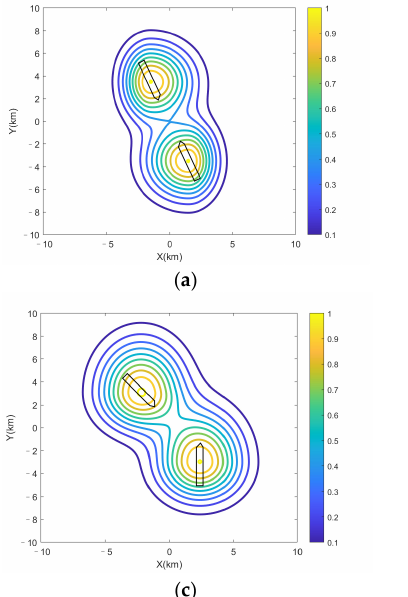
Figure 4. Schematic diagram of ship risk field in different situations: ( a ) schematic diagram of ship risk field in the head-on situation; ( b ) schematic diagram of ship risk field in the overtaking situation; ( c ) schematic diagram of ship risk field in the crossing situation.